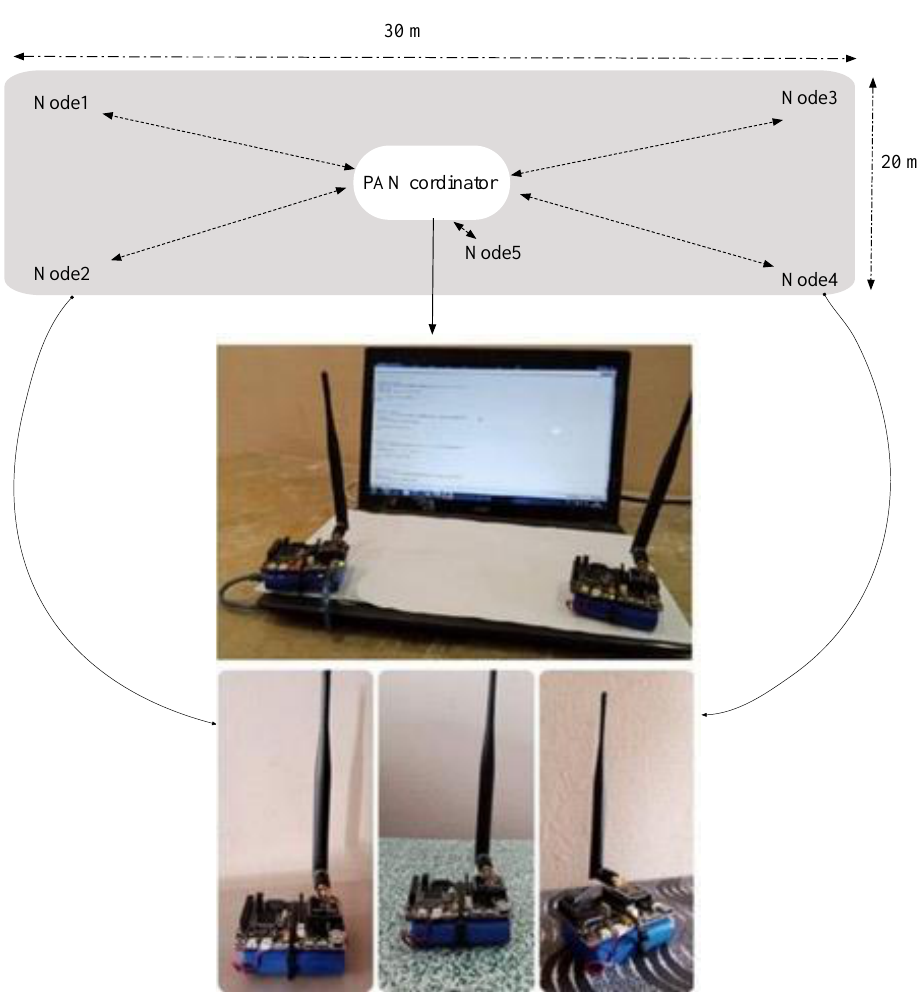
Figure 15. The testbed.